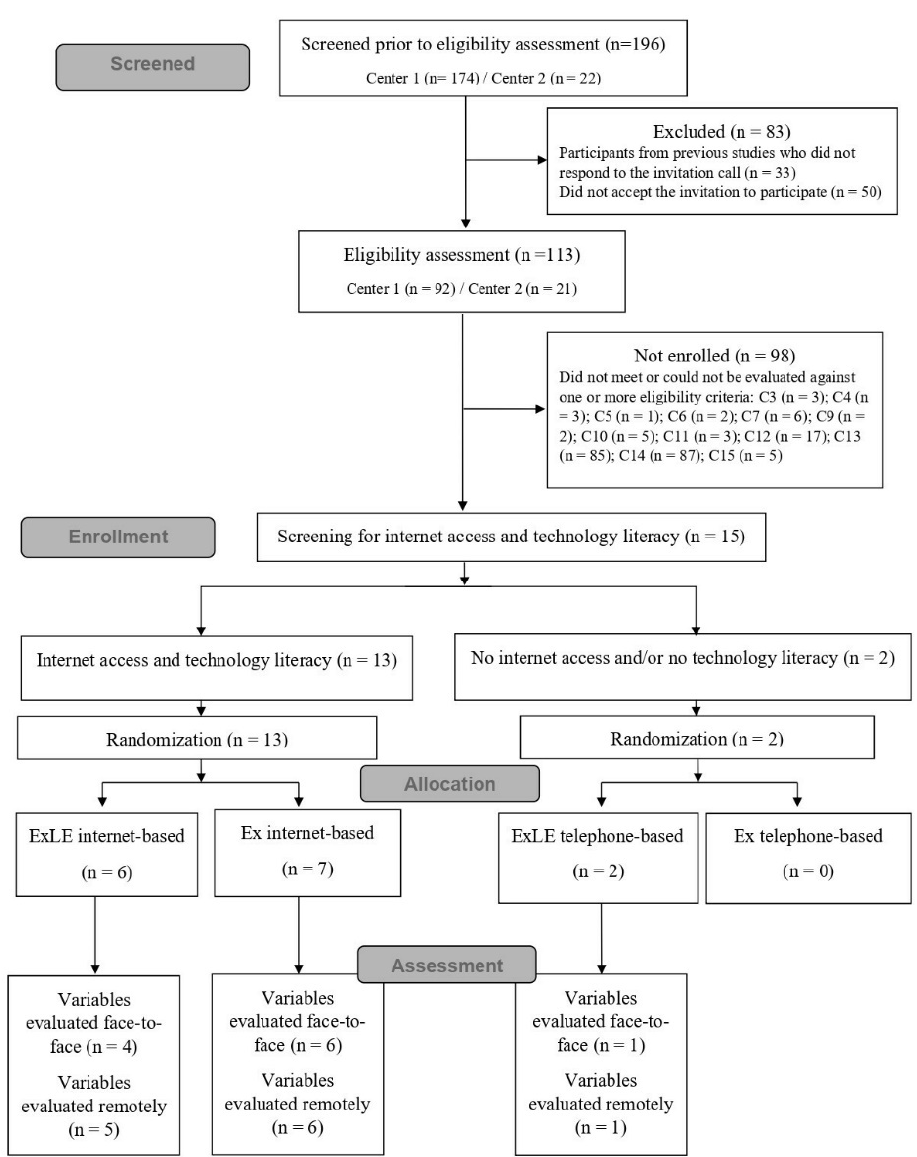
Figure 1. Flow diagram of participants through the study, including reasons for no eligibility assessment and no enrollment. C3: lack of cognitive limitation; C4: absence of unstable coronary artery disease; C5: absence of heart failure; C6: non-use of a pacemaker and/or implantable cardioverter defibrillator; C7: absence of intermittent claudication; C9:no complex arrhythmias; C10: no chest pain; C11: absence of a physical condition that limited or prevented the performance of exercises; C12: not currently participating in a structured exercise program; C13: written physician permission